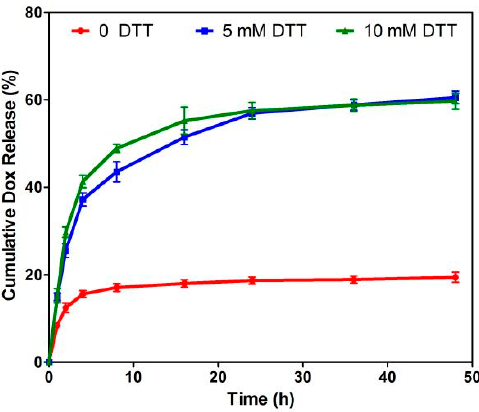
Figure 6. In vitro drug release of DOX-loaded polymer 3 micelles in PBS containing 0, 5, or 10 mM DTT.